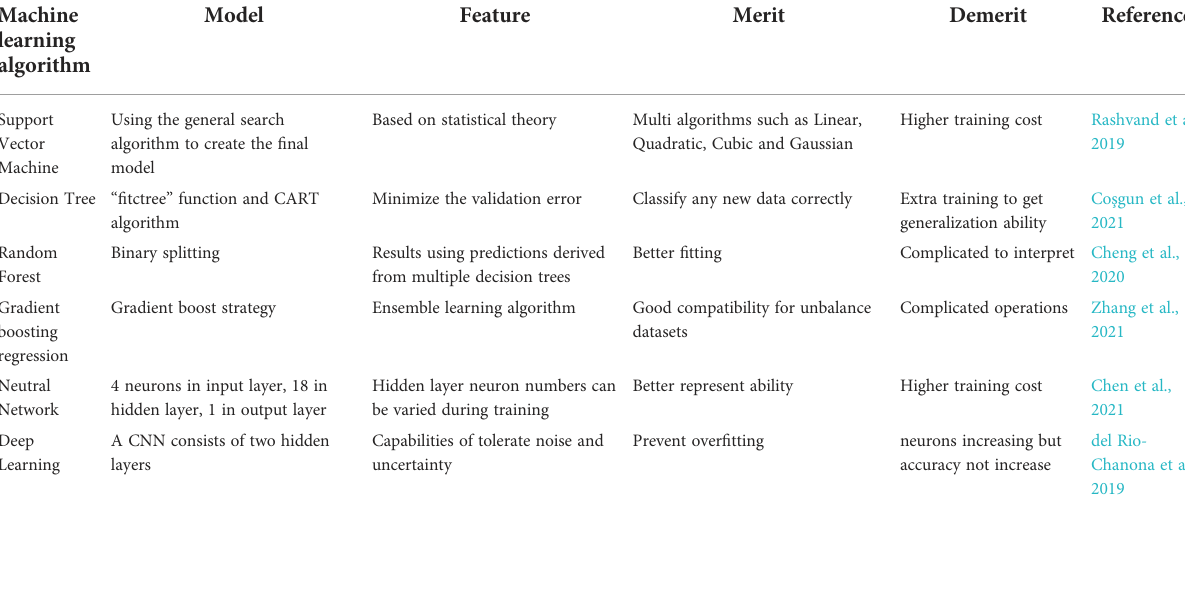
TABLE 2 Machine learning algorithms and models used in biofuel generation from microalgae.